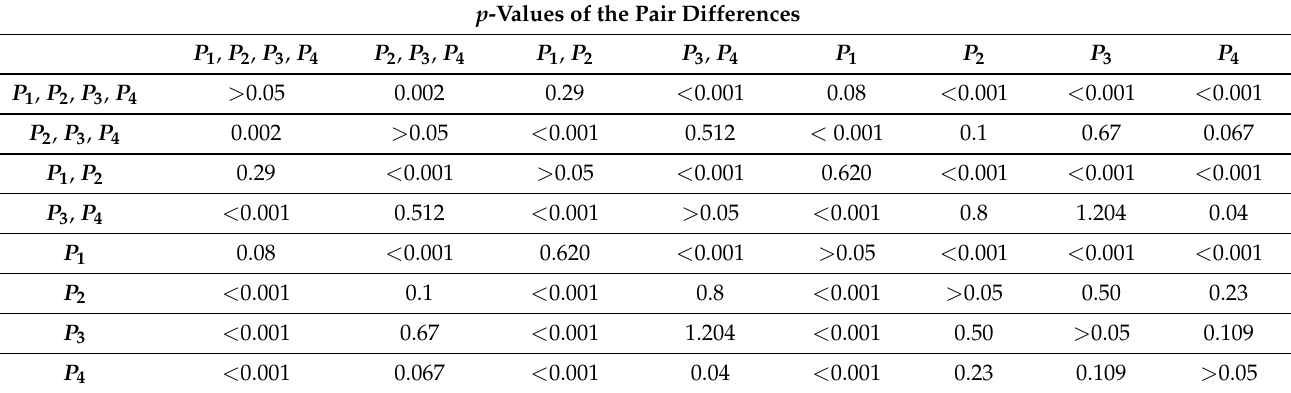
Table 3. Significance testing results regarding the differences in predicting the best price between pairs of opinions’